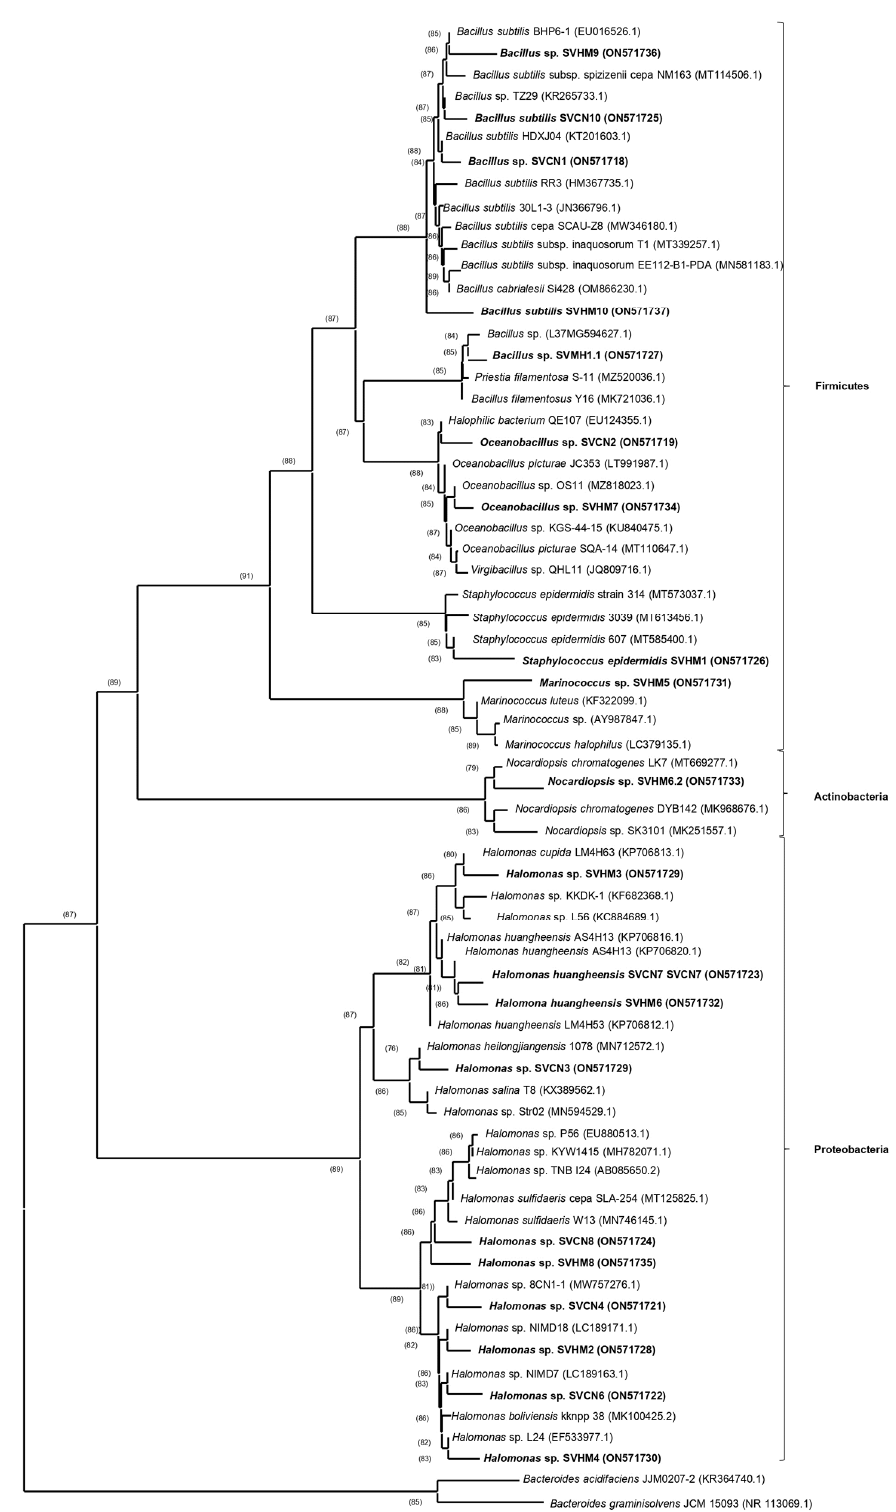
Figure 1. Phylogenetic cladogram of bacterial isolates from the root soil of S. verrucosum . The sequences used to construct the phylogenetic cladogram were obtained from selected bacterial databases based on BLAST results of 16S rRNA sequences identified by their GenBank accession number. The numbers on branches indicate bootstrap support (>50%) with at least 1000 replicas. The figures in parentheses indicate the percentage of coverage of the site. Bacteroides acidifaciens JJM0207-2 and Bacteroides graminisolvens JCM 15,093 are included as an